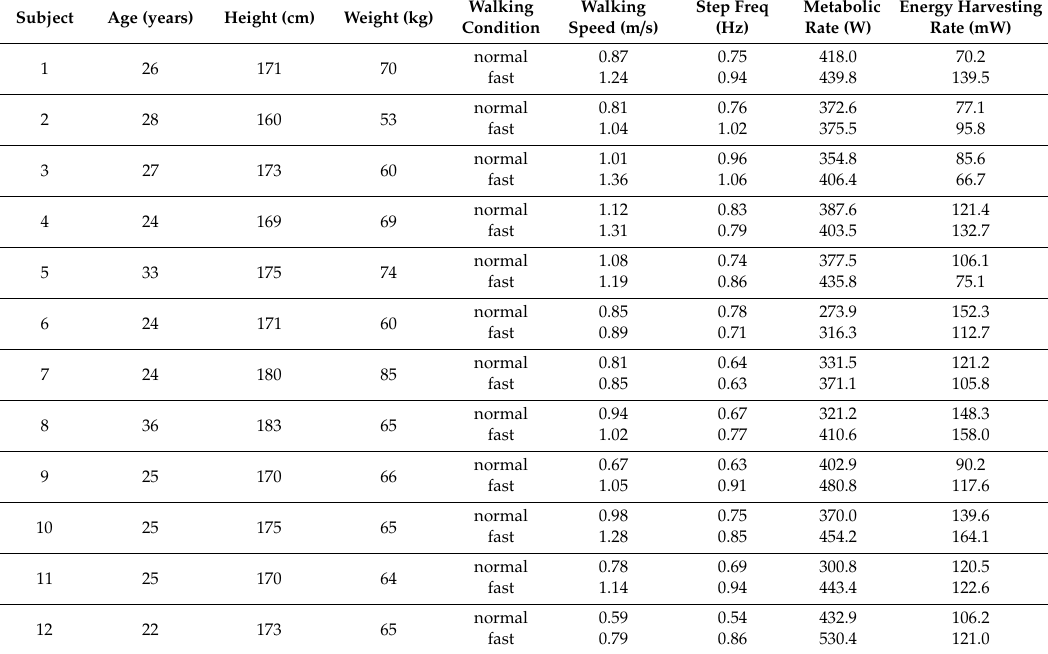
Table 1. Modeling parameters based on individual subject characteristics while walking with the custom sliding energy harvesting